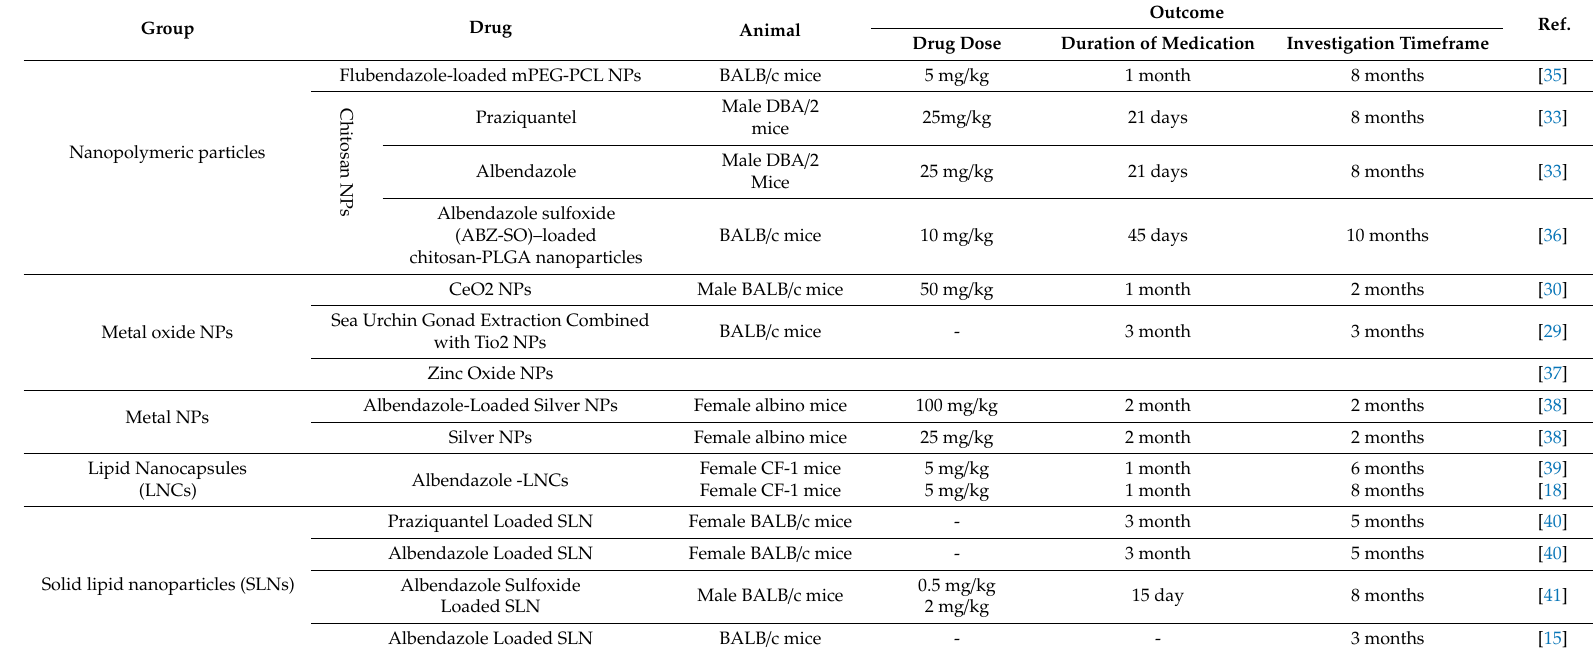
Table 2. A list of in vivo studies on e ff ects of nanoparticles against hydtid